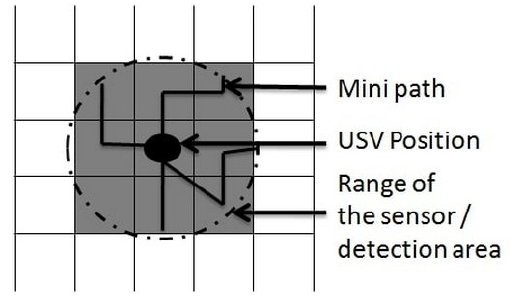
Figure 4: Trajectory planning